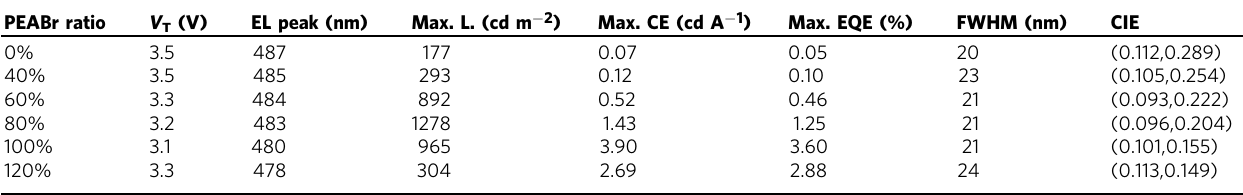
Table 1 Summary of CsPbCl 0.9 Br 2.1 perovskite LEDs with different ratios of PEABr PEABr